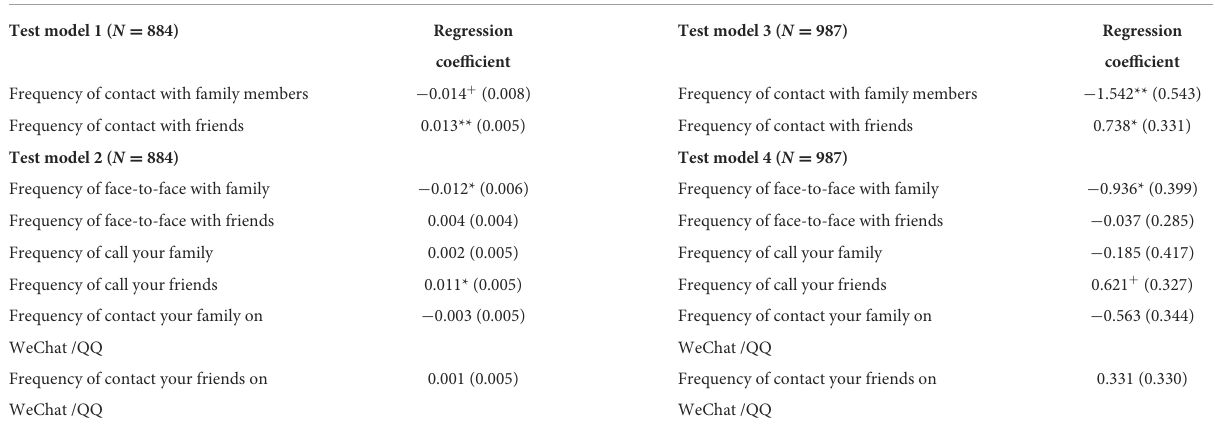
TABLE 6 Robustness test